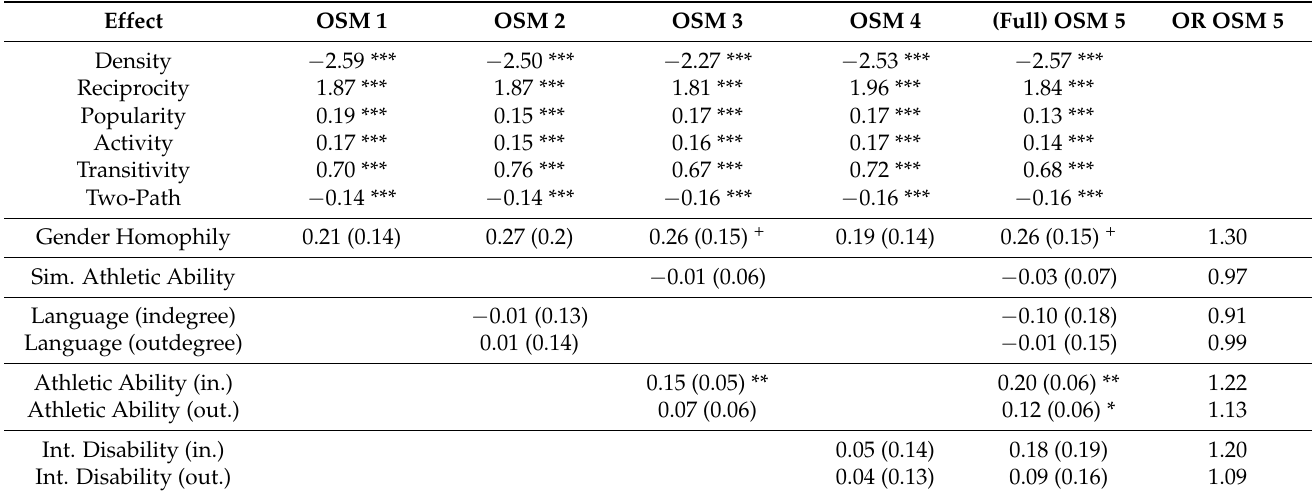
Table 4. Random-effects models for friendship networks in organized